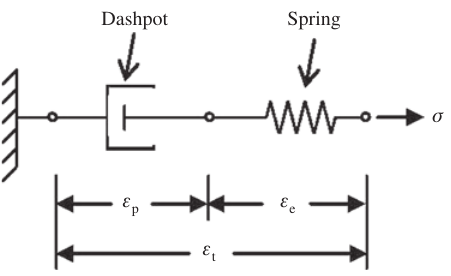
Figure 2: Maxwell model showing a schematic of elastic and plastic behaviors.